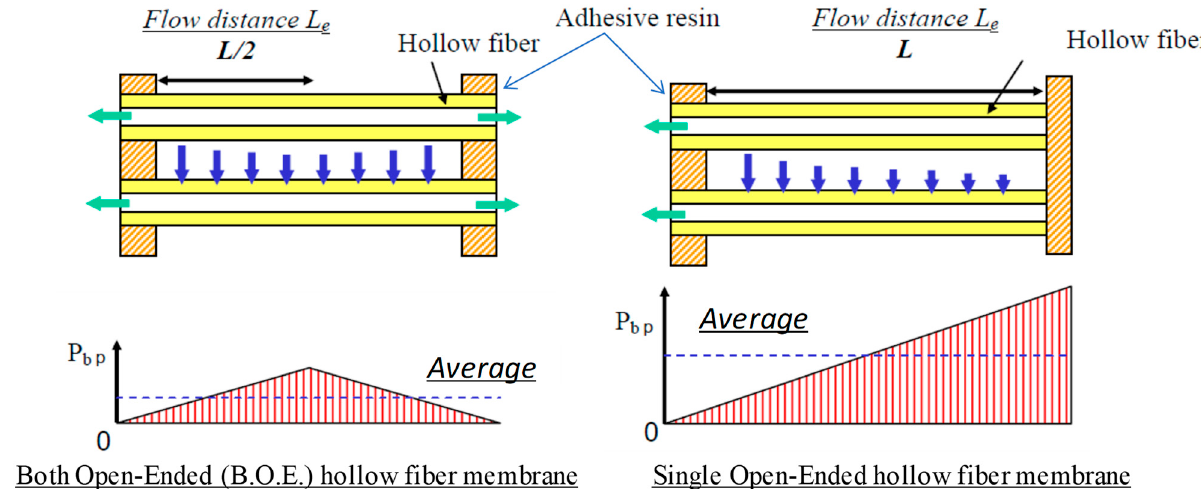
Figure 5. Comparison of fouling tendency in membrane type [38].